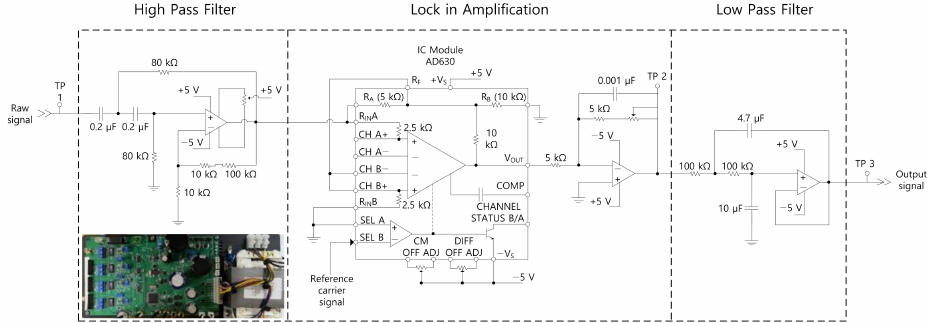
Figure 2. Electronic circuit diagram of a single signal processing channel. The circuit contains an HPF, a demodulator, an LPF, and op-amps at each stage. The HPF design included an 80 k Ω resistor and a 0.2 µ F capacitor used to set a cut-off frequency of 10 Hz. The demodulated signal was obtained after HPF was connected to the input line of IC chip (AD630) with a gain of 2. The LPF comprised a 100 k Ω resistor and 4.7 µ F and 10 µ F capacitors used to set a cut-off frequency of 0.23 Hz. Only the DC component was extracted after removing random noise. The op-amps were configured at each stage for signal amplification. The typical amplification factor was